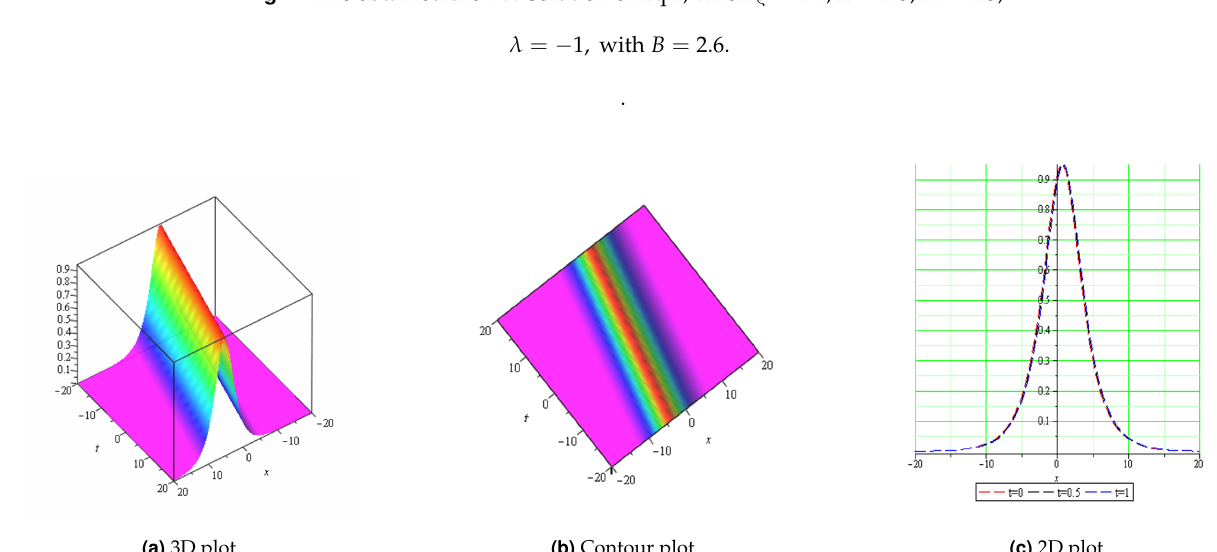
Fig. 2. The obtained the TW solution of Eq 2, when ϱ = 0.6, Ξ = 1, Π = 0.75, λ = − 0.2,a = 0.5, b = 1.5,c = 1, and y = 1 with B =